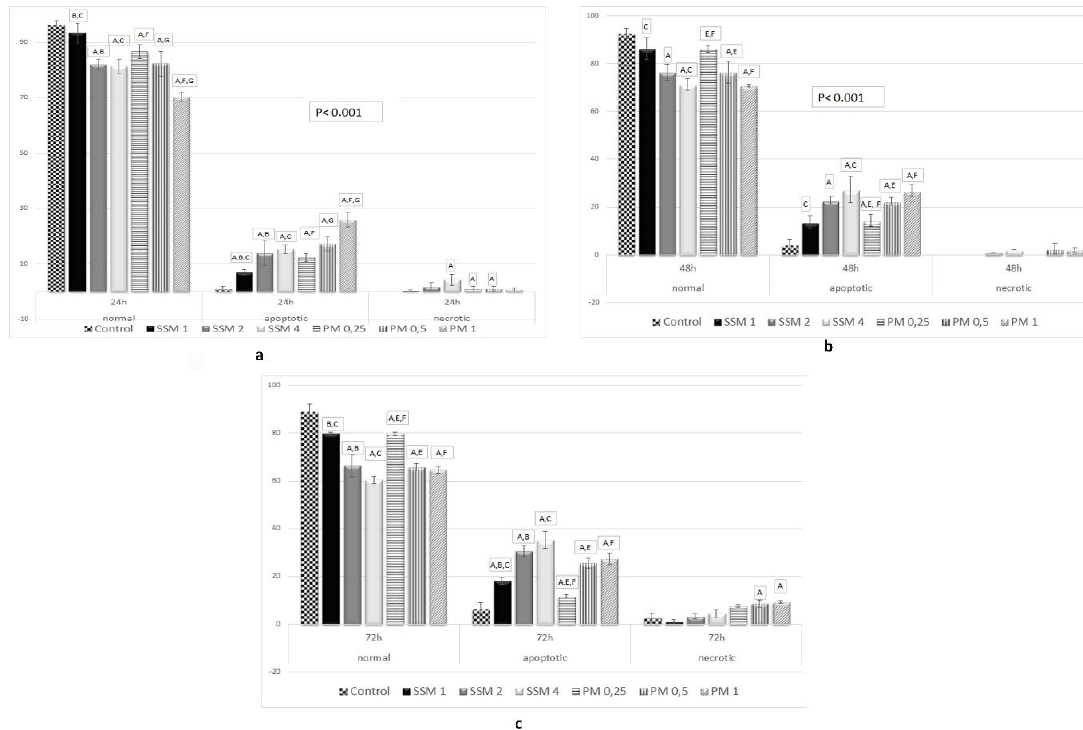
Figure 7. Different morphological patterns of cell death induced by 4 mg/mL of SSM and 1 mg/mL of PM on L-929 cells compared to non-treated ones after 24, 48 and 72 h incubation. Green live cells show normal morphology; green early apoptotic cells show nuclear margination and chromatin condensation. Late orange apoptotic cells showed fragmented chromatin and apoptotic bodies. Necrotic cells stain uniformly red.